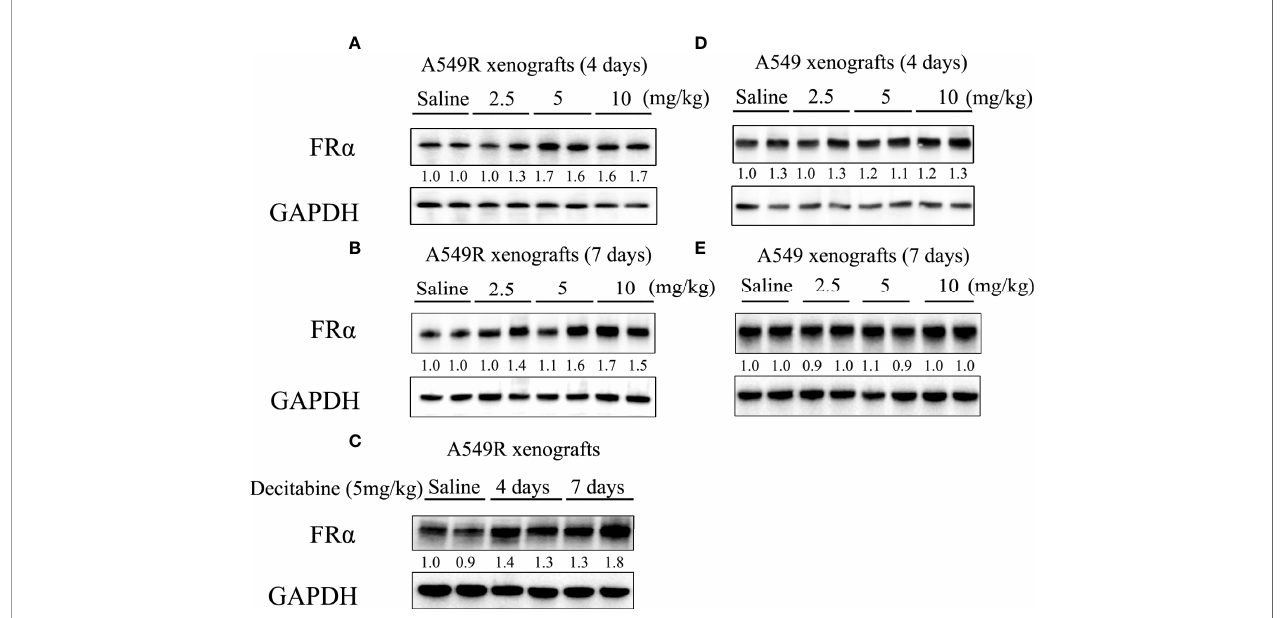
FIGURE 6 | FR a protein expression in xenograft tumors from mice treated with decitabine. (A, B) FR a expression in A549R xenograft tumors. Mice were intraperitoneally injected with different doses (2.5, 5, or 10 mg/kg) of DAC on day 0, and tumors were collected on days 4 and 7. (C) Comparison of FR a expression in A549R xenograft tumors collected on day 4 and 7. (D, E) FR a expression in A549 xenograft tumors. Mice were intraperitoneally injected with different doses (2.5, 5, or 10 mg/kg) of DAC on day 0, and tumors were collected on day 4 and 7. Densitometric values are shown as optical density after GAPDH normalization using Image J and each band represents a